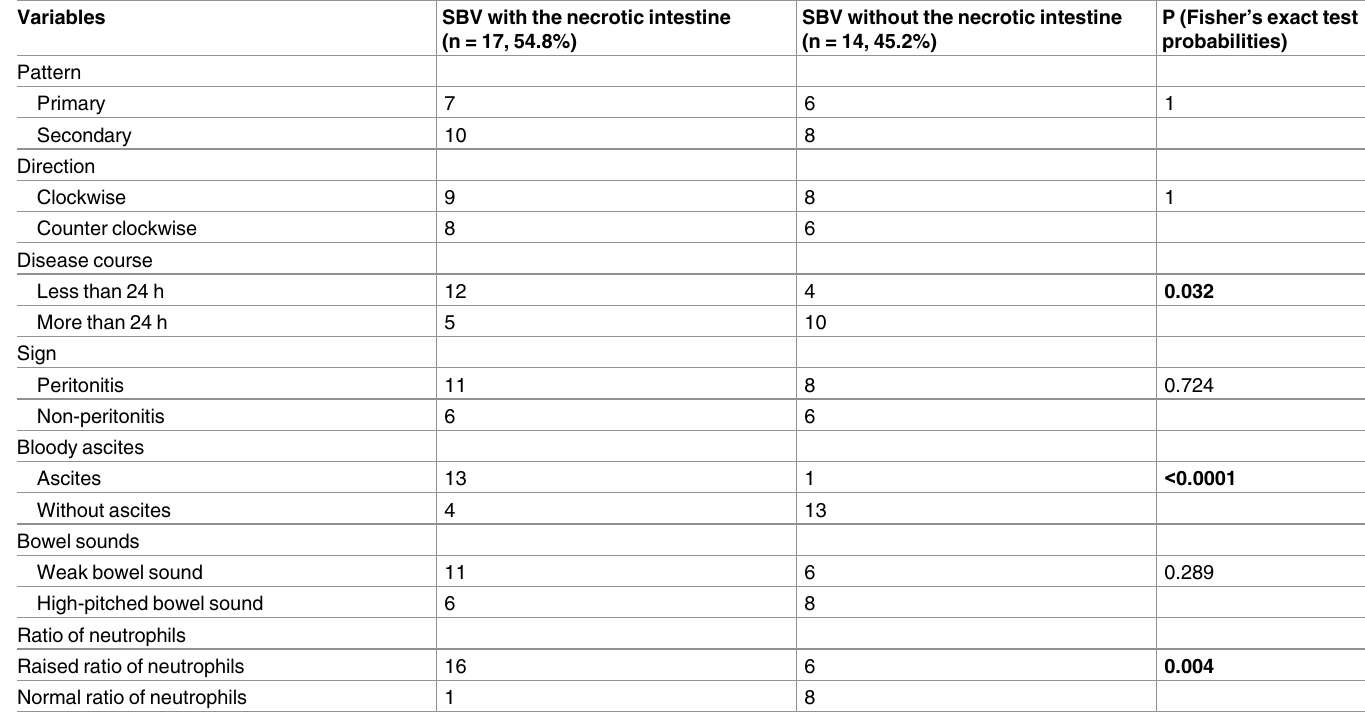
Table 3. Statistical analysis of clinical characteristics between small bowel volvulus with and without the necrotic intestine.